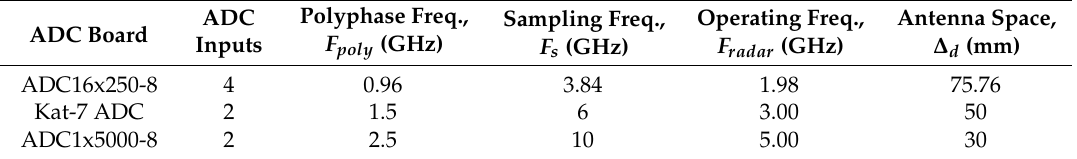
Table 3. Achievable operating speeds of the proposed 3D radar at different ADC sampling rates.